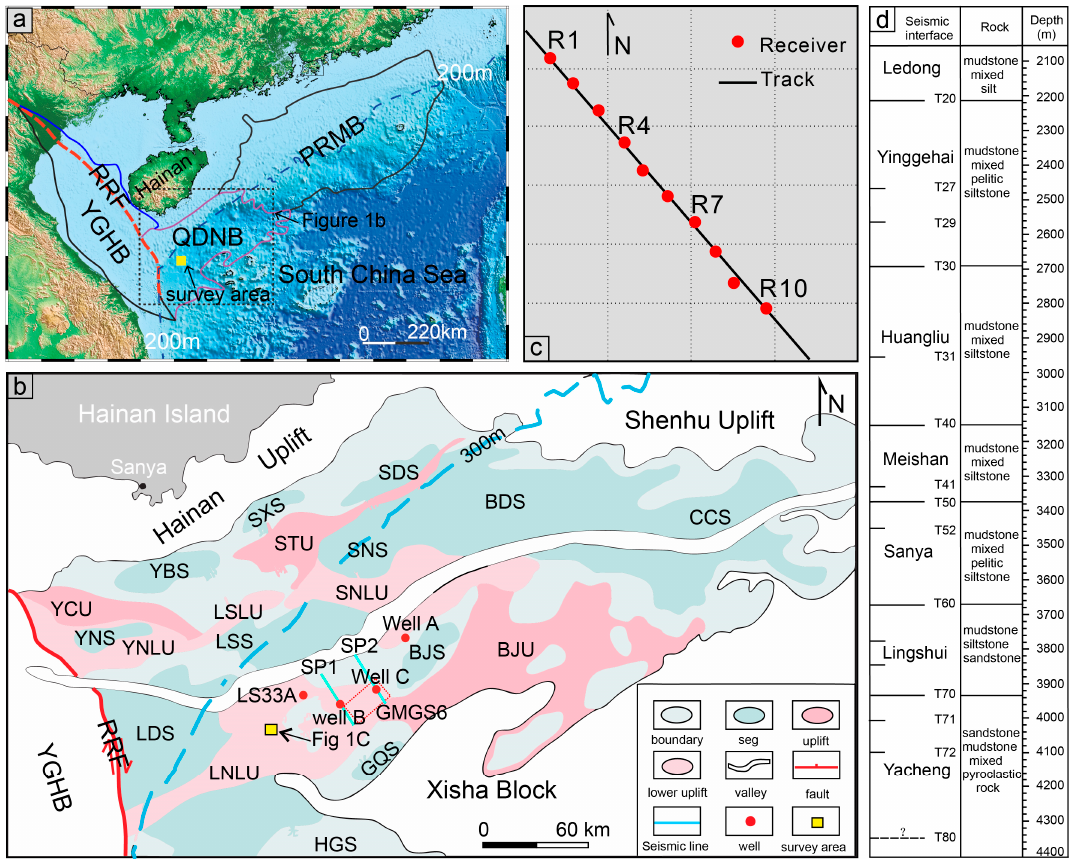
Figure 1. The location and strata of the QDNB: ( a ) Geographical location of the QDNB; ( b ) Tectonic units of the QDNB (modi fi ed from Reference [9]); ( c ) Location of MCSEM receivers; ( d ) Stratigraphic units of the QDNB (modified from Reference [9]); ( c ) Location of MCSEM receivers; ( d ) Stratigraphic column of the QDNB (modi fi ed from References [42,45]). The solid, blue lines (SP1 and SP2) are column of the QDNB (modified from References [42,45]). The solid, blue lines (SP1 and SP2) are seismic lines (modi fi ed from Reference [46]). YGHB: Yinggehai Basin; QDNB: Qiongdongnan Basin; seismic lines (modified from Reference [46]). YGHB: Yinggehai Basin; QDNB: Qiongdongnan Basin; PRMB: Pearl River Mouth Basin; RRF: Red River Fault. PRMB: Pearl River Mouth Basin; RRF: Red River